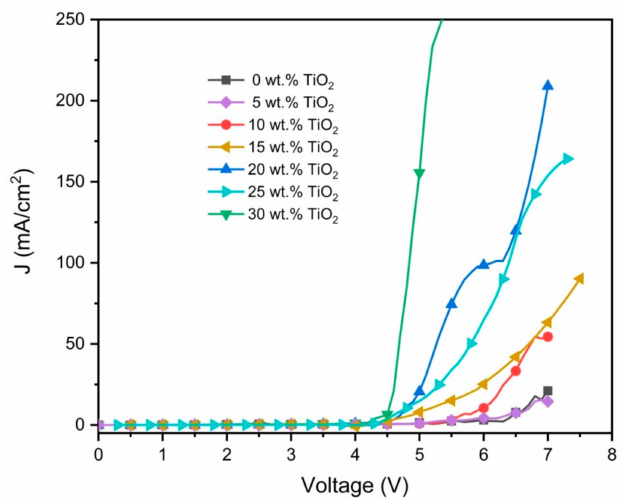
Figure 9. Current density–voltage (J-V) characteristics of the nanocomposite thin